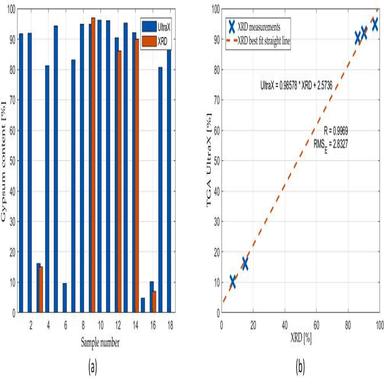
Comparison of analyses data from the TGA UltraX-system and XRD-measurements.